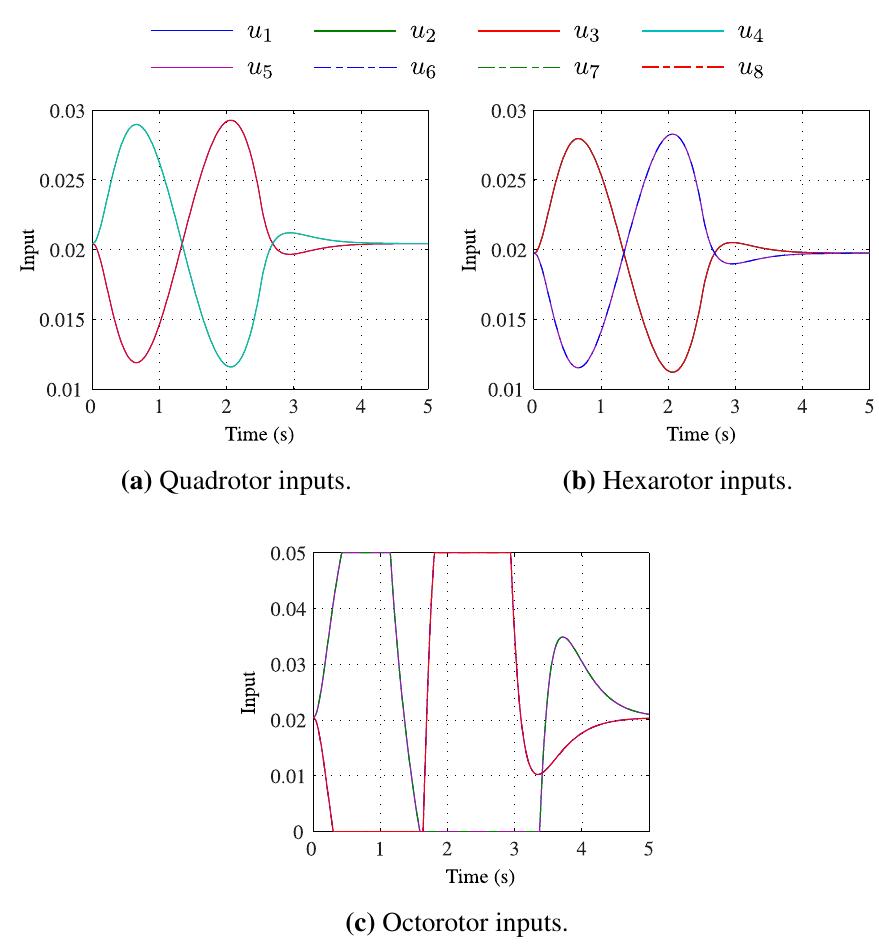
Figure 14. Rotor input histories for each configuration while performing a fast yaw